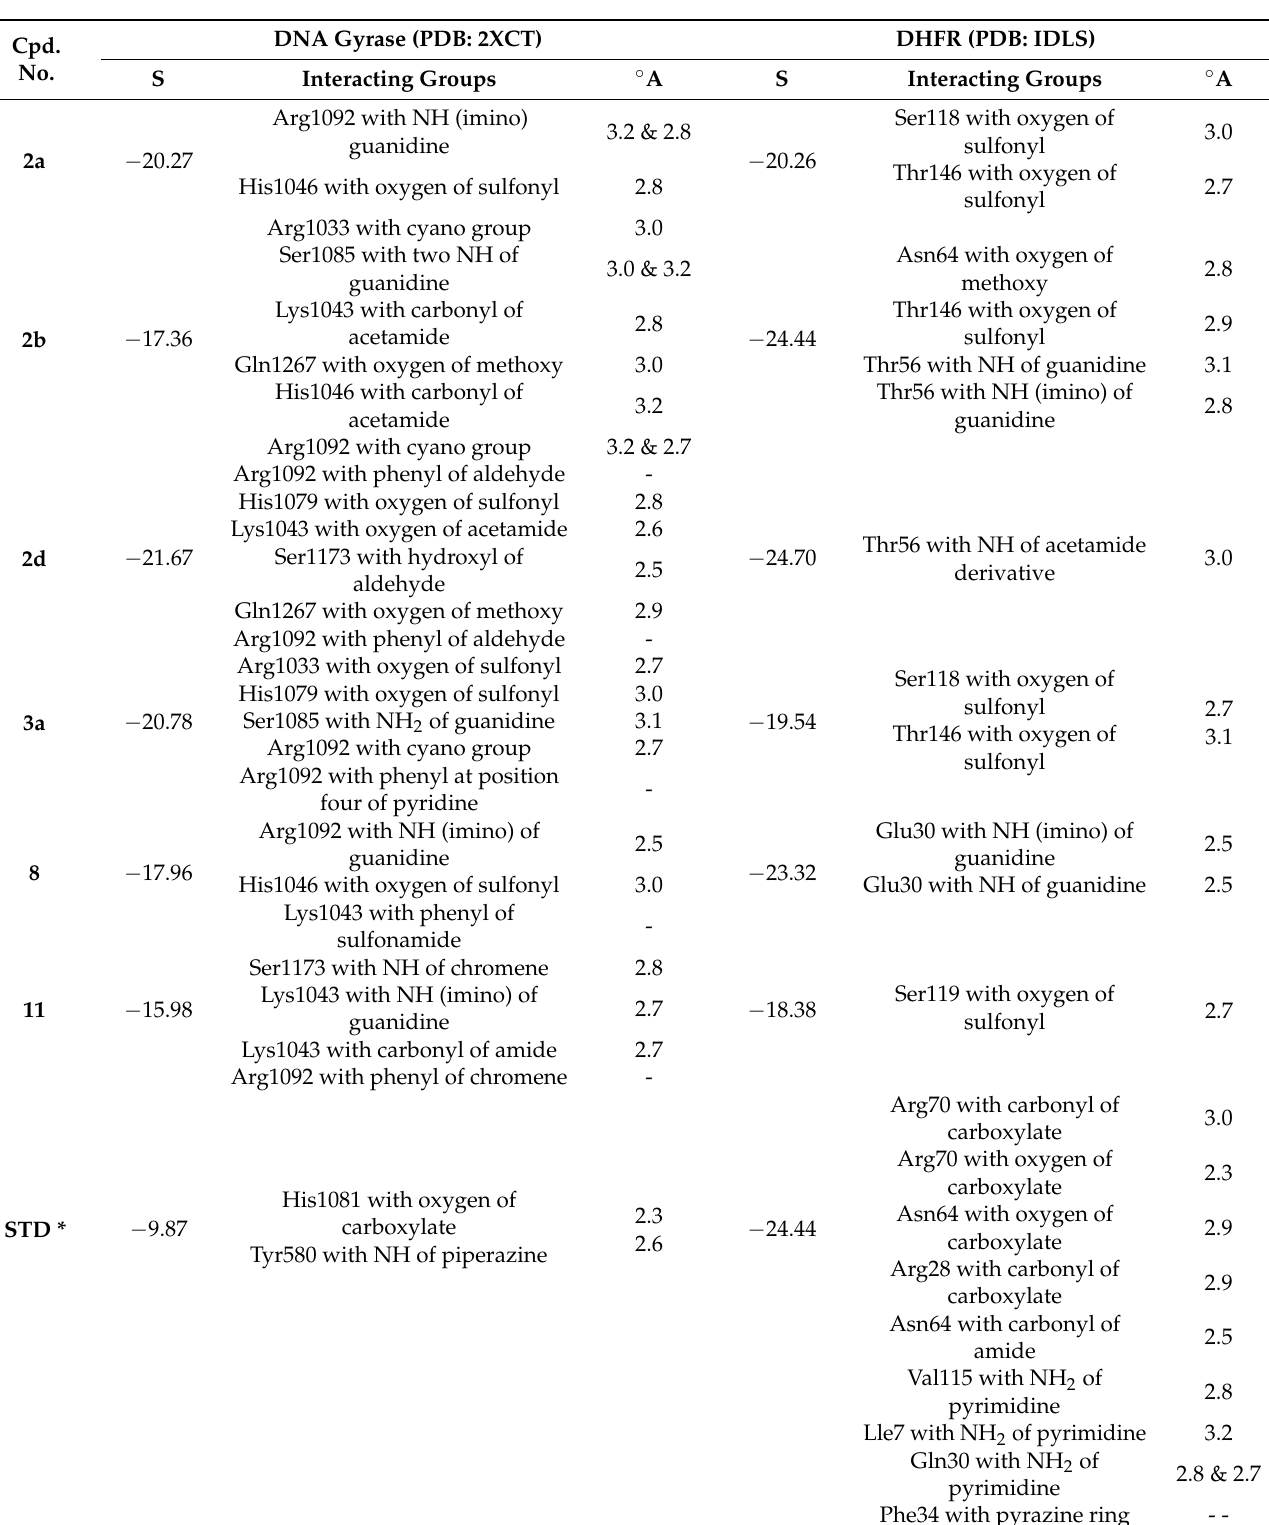
Table 12. Molecular modeling study of the most promising derivatives 2a , 2b , 2d , 3a , 8 , and 11 against DNA gyrase (PDB: 2XCT) and DHFR (PDB: IDLS).